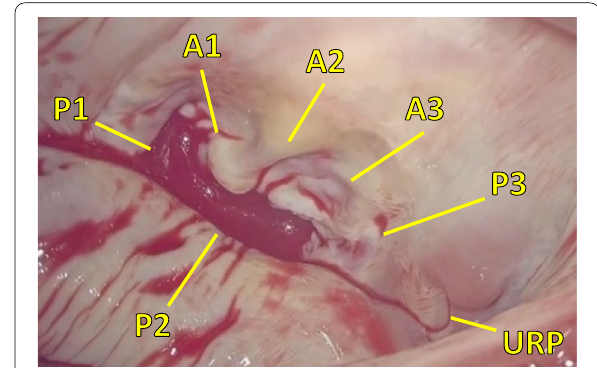
Fig. 3 Intraoperative findings of the unroofed portion. Intraoperative findings showed the unroofed portion detected at the atrial side between segments P2 and P3 of the posterior mitral leaflet, similar to findings of preoperative transesophageal echocardiography. P1 P1 segment of posterior mitral leaflet, P2 P2 segment of posterior mitral leaflet, P3 P3 segment of posterior mitral leaflet, A1 A1 segment of anterior mitral leaflet, A2 A2 segment of anterior mitral leaflet, A3 A3 segment of anterior mitral leaflet, URP unroofed portion